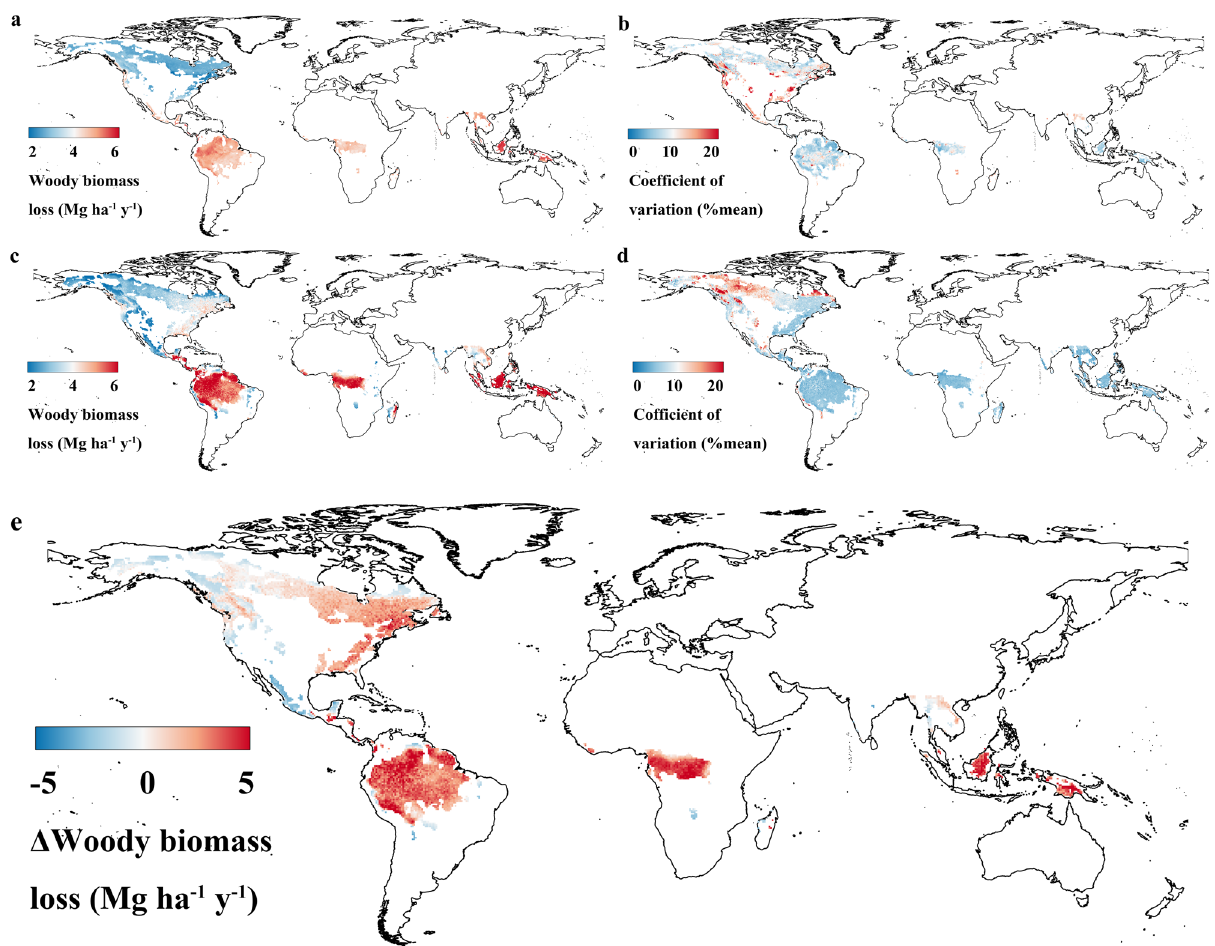
Fig. 2 Map of biomass loss to mortality (LOSS) and its uncertainty across continents. a , b Ensemble mean of LOSS a and its uncertainty (coef fi cient of variation, b across continents at 0.25 degree derived from forest plot data using the bootstrapped (10 iterations) approach by randomly sampling 90% plots with replacement. c , d Ensemble mean of LOSS c and its uncertainty (coef fi cient of variation, d across continents at 0.5 degree derived from six dynamic vegetation models (DGVMs, ORCHIDEE, CABLE-POP, JULES, LPJ-GUESS, LPJmL, and SEIB-DGVM). Coef fi cient of variation was quanti fi ed as the standard deviation divided by the mean predicted value as a measure of prediction accuracy. e The difference of LOSS between ensemble mean of DGVMs and ensemble mean of LOSS derived from forest plots data across continents at 0.5 degree, quanti fi ed as difference between c and a , whereby LOSS in Fig. 2a is resampled at 0.5 original plot data of LOSS: R 2 = 0.68 and P = 0.04 for grid-level NPP; R 2 = 0.97 and P = 0.0001 for grid-level HR; the scenario of